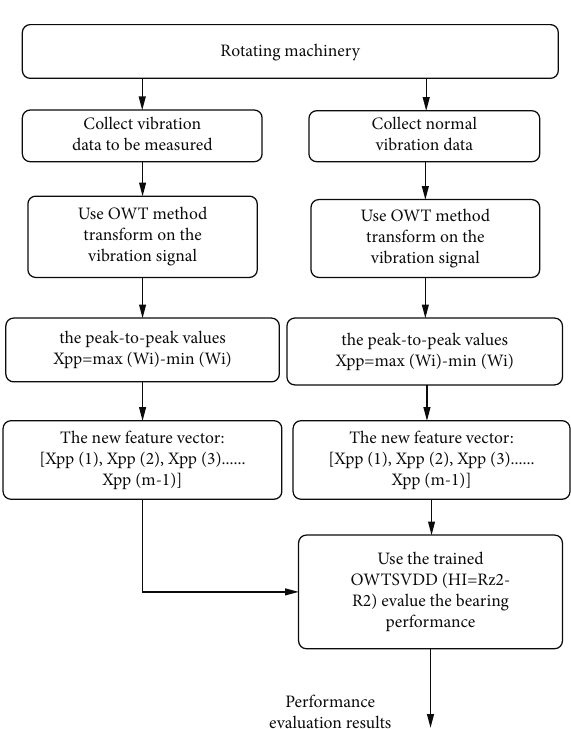
Figure 4: Flow chart of performance degeneration